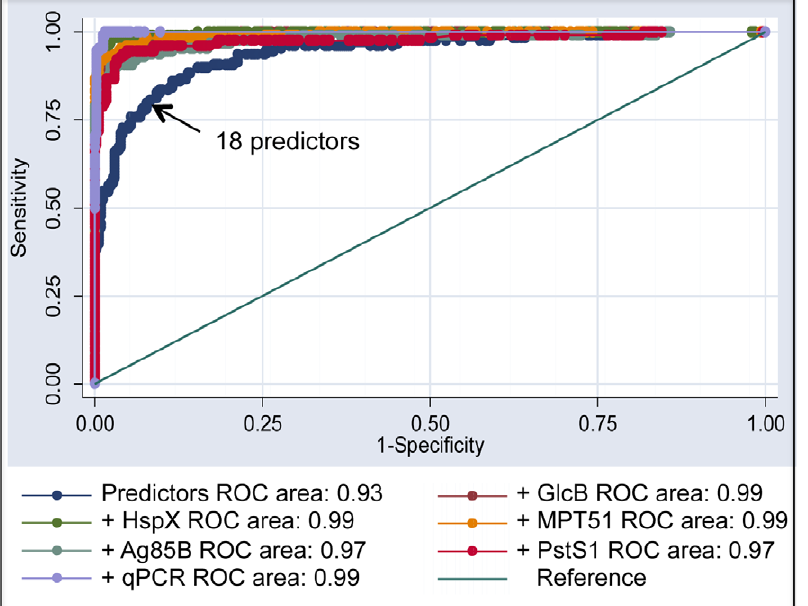
Figure 4. ROC curves for logistic regression analysis of ‘Probable and Possible’ TBM samples. Predictor model (18 predictors) applied to ‘Probable and Possible’ TBM combined with ELISA/qPCR.